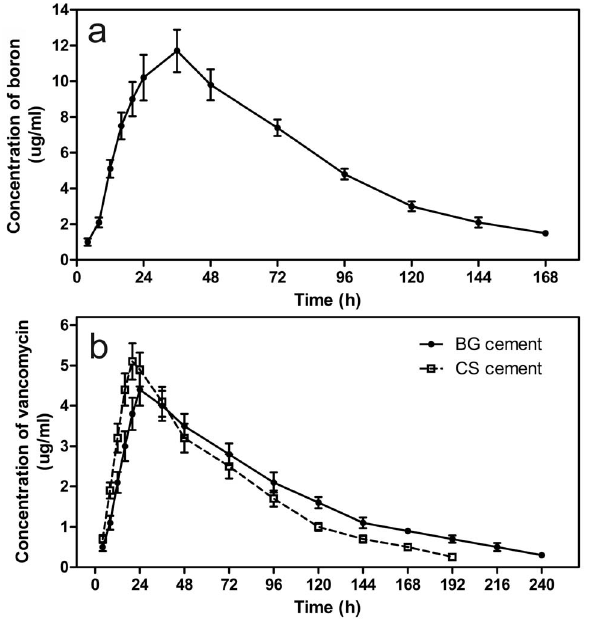
Figure 7. Radiographics analysis of animals before surgery and at 2 months post-surgery. Representative preoperative radiographs showing tibial osteomyelitis in the four different groups (1a, 2a, 3a, 4a), characterized by bone destruction (arrows), periosteal new bone formation (arrowhead) and sequestral bone formation (asterisk). (1b) Postoperative radiographs of Group 1 showed deterioration of osteomyelitis coupled with periosteal new bone formation (arrowhead), destruction of bone (arrows) and sequestral bone formation (asterisk). (2b) Postoperative radiographs of Group 2 showed that the osteomy- elitis was partly controlled. (3b, 4b) Postoperative radiographs of Group 3 and Group 4 showed that the osteomyelitis was healed.